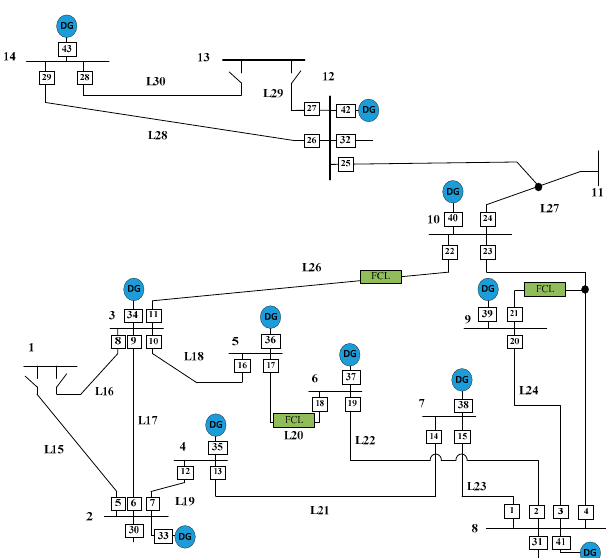
Figure 6. Single-line diagram of the 30-bus test system. Energies 2018 , 11 , x